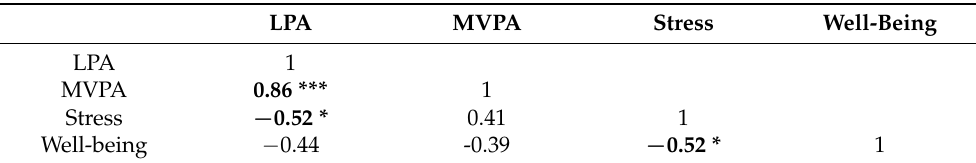
Table 4. Pearson product-moment correlations between outcomes at